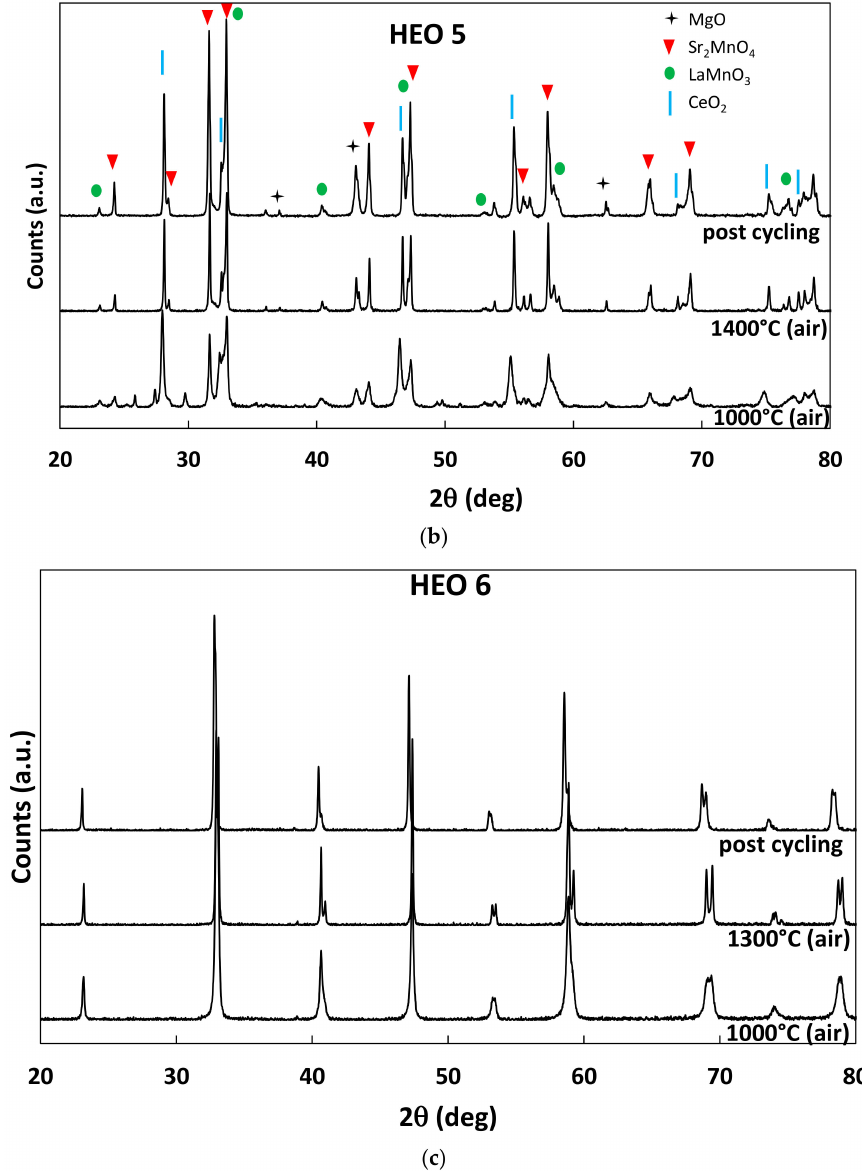
Figure 9. XRD analysis of ( a ) HEO 4, ( b ) HEO 5 and ( c ) HEO 6 after different heat treatments in air (1 h) and after thermochemical